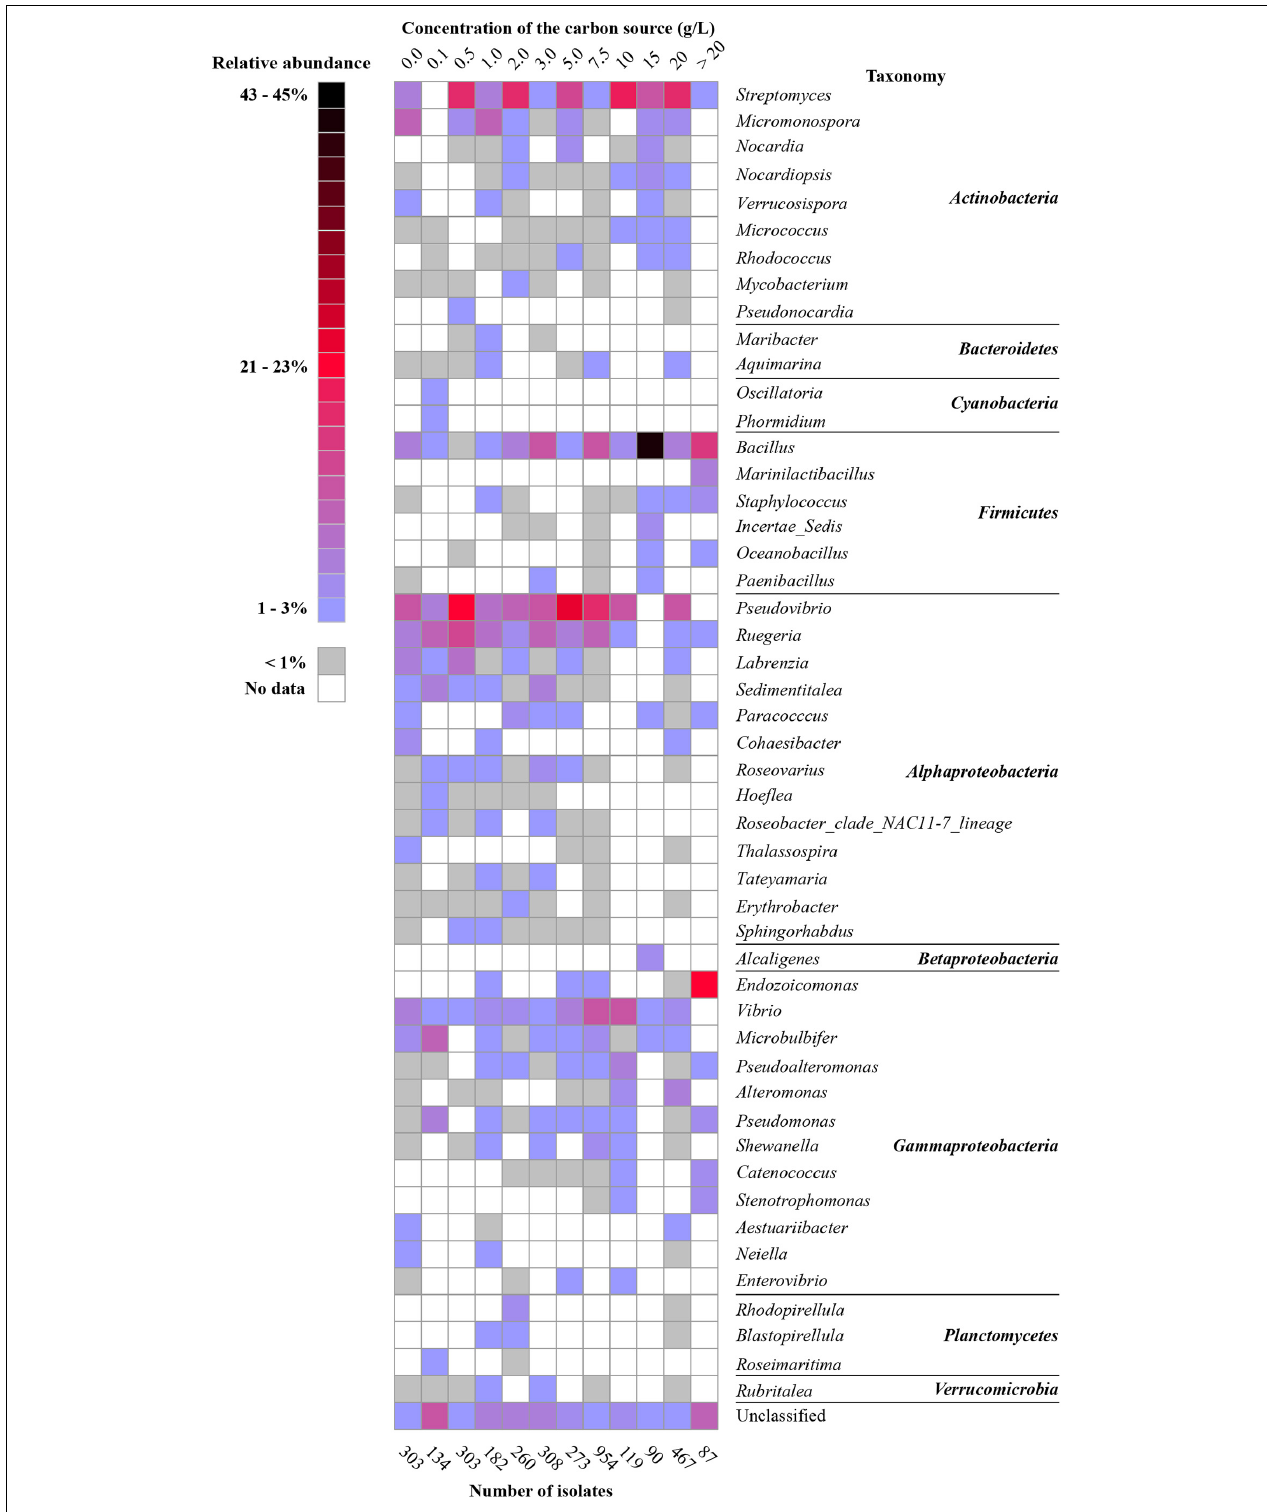
FIGURE 4 | Heat map of the most abundant genera (50 genera) based on carbon amount in culture media. The percentage was calculated for each of the categories (sum for each column is 100%).